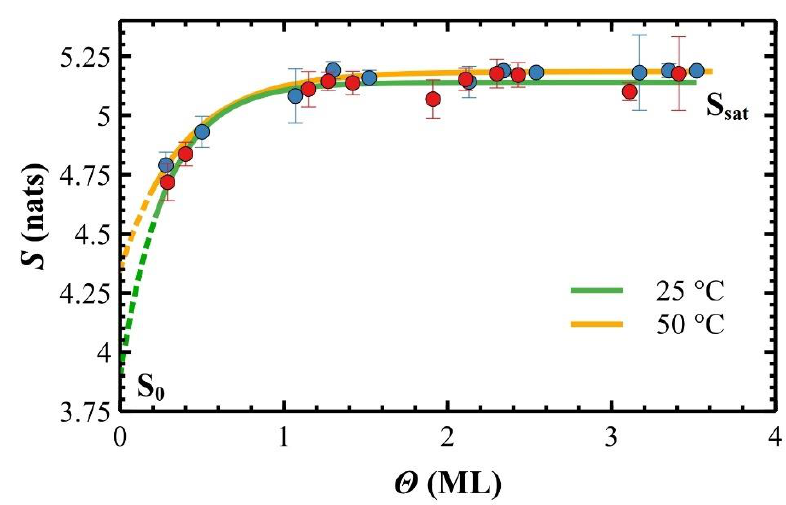
Figure 6. Data plots of S versus Θ at 25 and 50 °C fitted by an exponential plateau equation (Equation (2)).